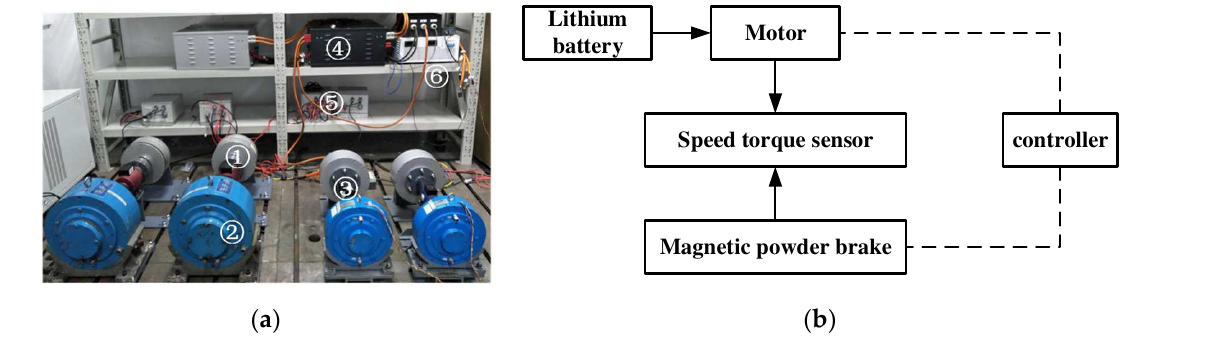
Figure 4. Structural composition of motor test bench. Note: ① Motor used in the research; ② mag- netic powder brake; ③ speed torque sensor; ④ lithium battery; ⑤ motor controller; ⑥ power management system. ( a ) The picture of test site; ( b ) Schematic diagram.